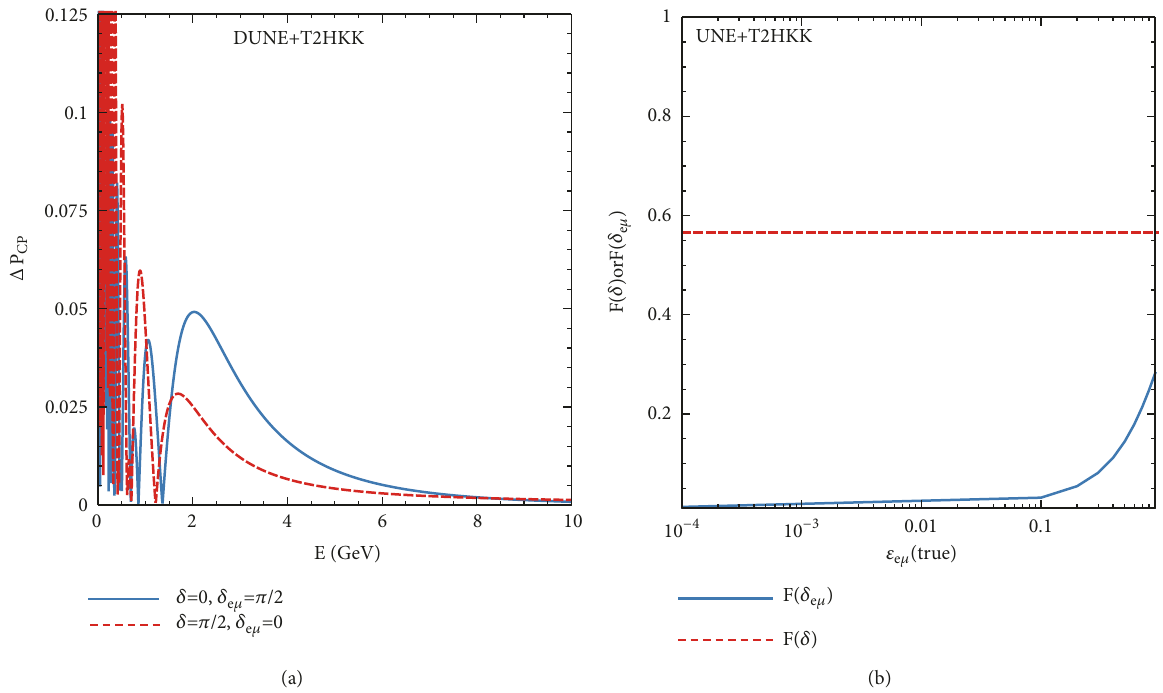
Figure 6: The 𝐶𝑃 asymmetry as function of neutrino beam energy 𝐸 for DUNE+T2HKK (left panel). The 𝐶𝑃 fractions corresponding to 𝛿 and 𝛿 푒휇 for which significance ≥ 3 𝜎 (right